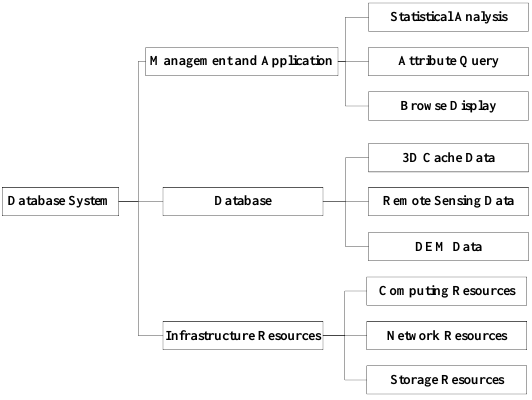
Figure 4 . Cache Data Production and Database Construction of 3D City Modeling Cache